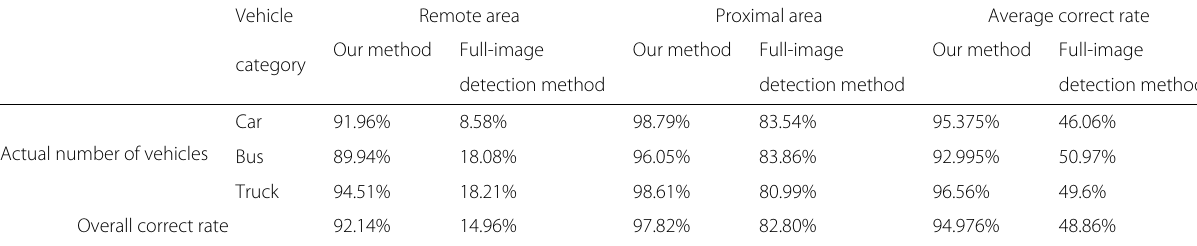
Table 3 Comparison of actual vehicle numbers by using different methods